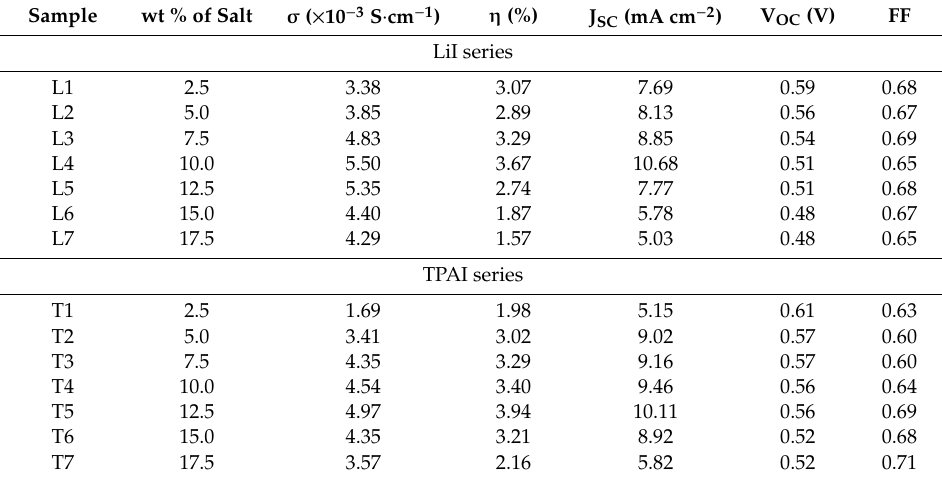
Table 2. JV parameters of phthaloyl starch and the HEC based